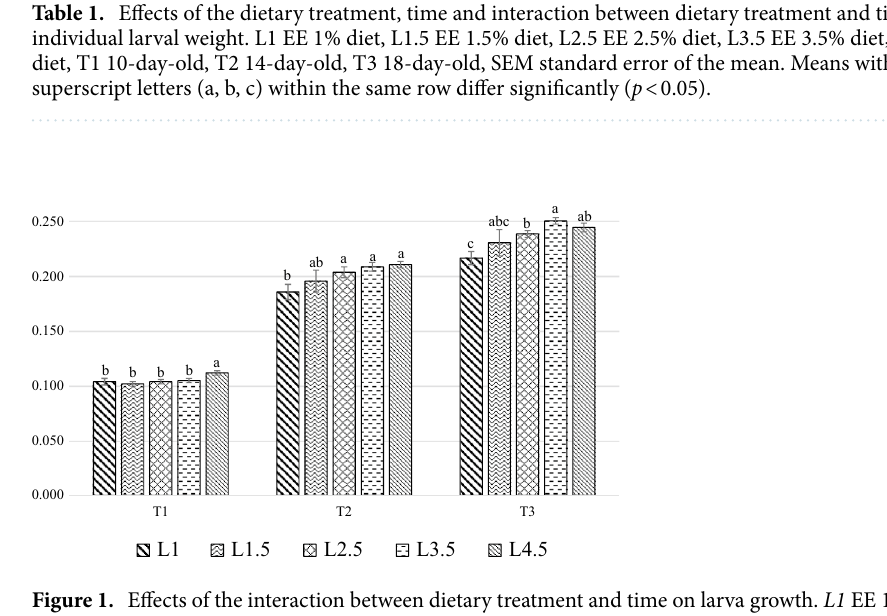
Figure 1. Effects of the interaction between dietary treatment and time on larva growth. L1 EE 1% diet, L1.5 EE 1.5% diet, L2.5 EE 2.5% diet, L3.5 EE 3.5% diet, L4.5 EE 4.5% diet, GA Gainesville diet, T1 10 day old, T2 14 day old, T3 18 day old. Means with different superscript letters (a, b, c) within the same row differ significantly ( p < 0.05). The standard error is represented by the error